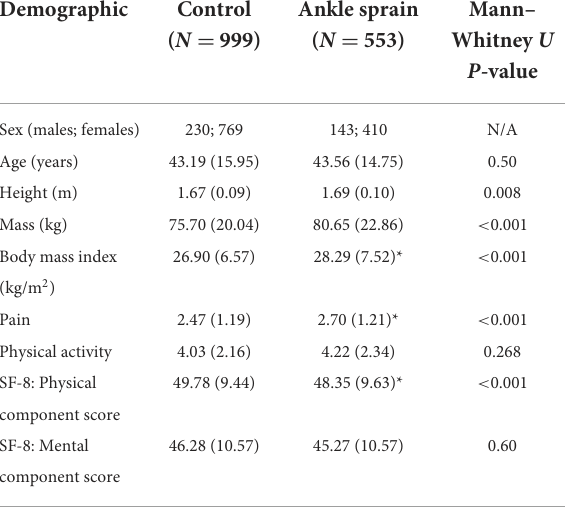
TABLE 1 Respondent demographics and group comparisons: Ankle sprain vs. control